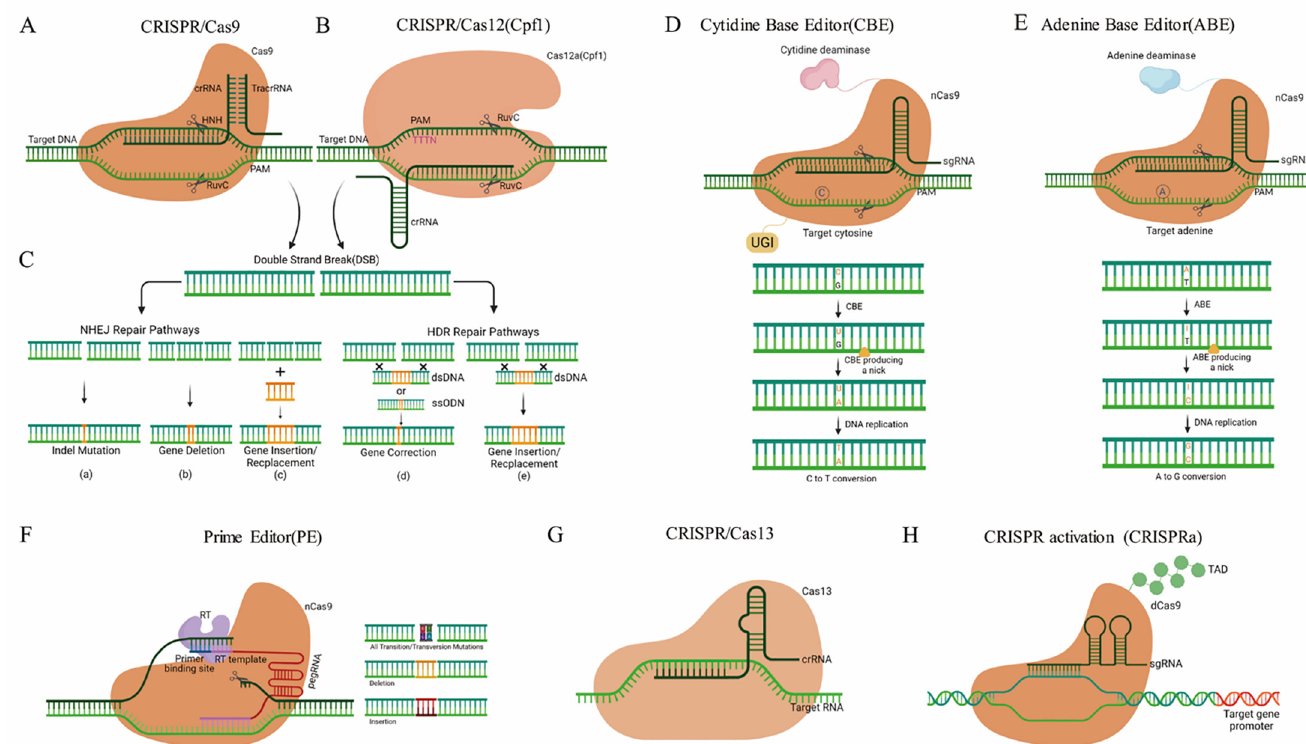
Figure 2. The methodology of major CRISPR/Cas systems. ( A ) CRISPR/Cas9 induces double-stranded breaks (DSBs) in DNA strands. ( B ) CRISPR/Cas12a cleaves the target DNA and introduces DSBs. ( C ) CRISPR/Cas methods can achieve different research goals: (a–c) are results of non-homologous end-joining NHEJ, and (d,e) are results of the homology-directed repair HDR repair pathways using a donor DNA template. ( D – F ) Base editing tools mainly include Cytidine Base Editor (CBE), Adenine Base Editor (ABE), and Prime Editor (PE). ( D ) CBE converts C-G base pairs to T-A base pairs at the target site. ( E ) ABE converts A-T base pairs to G-C base pairs at the target site. ( F ) PE is a new base editing system, which enables precise sequence substitution, insertion, and deletion. PE mainly consists of a Cas9 nickase (nCas9), an engineered reverse transcriptase (RT), and pegRNA. PegRNA includes PBS (Primer Binding Site) sequence and RT Template. ( G ) CRISPR/Cas13 consists of a Cas13, a crRNA, and a target RNA. Cas13:crRNA complexes bind target RNA and cleave the target RNA. ( H ) CRISPR transcriptional activation (CRISPRa) consists of a nuclease-deficient Cas9 (dCas9) and transcription activation domain (TAD). CRISPRa activates the transcription of single or multiple target genes.